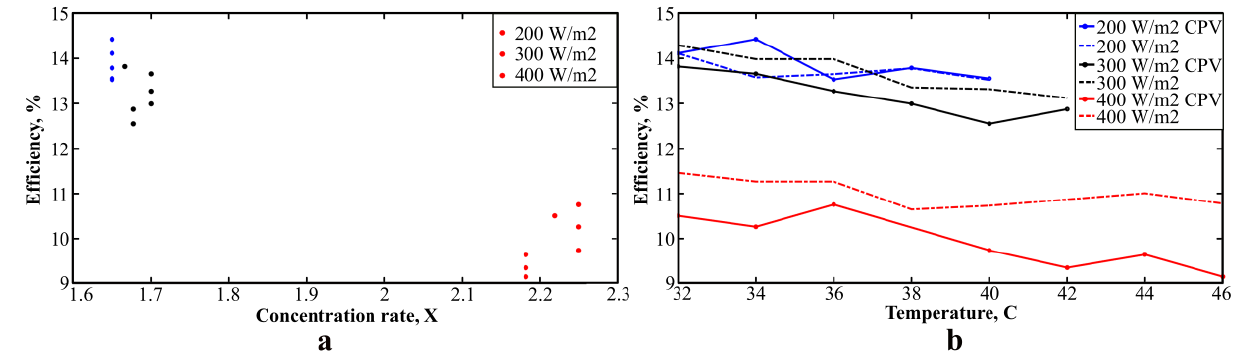
Figure 8. Efficiency as a function of ( a ) concentration ratio and ( b ) temperature and radiation power. Using the obtained parameters of the solar cell at different temperatures and solar radiations, we will make an approximation for these parameters for real power levels on a clear sunny day on 23 August 2021 in Almaty, Kazakhstan. Figure 9 shows experimentally measured values of solar radiation on the day of 23 August 2021 in Almaty, Kazakhstan.